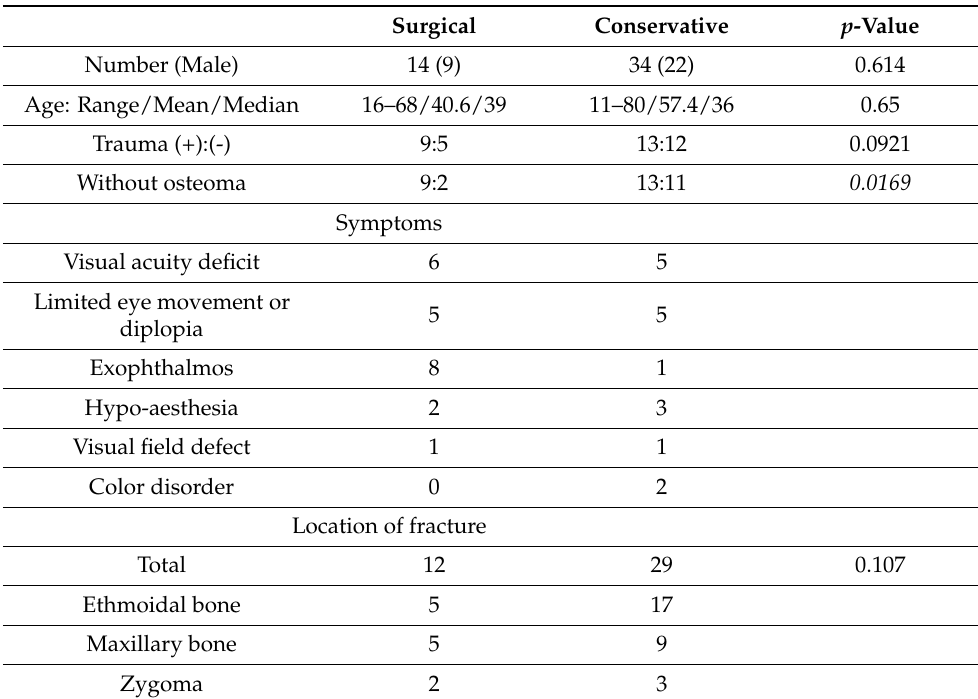
Table 2. Comparison between surgical and conservative cases. Surgical